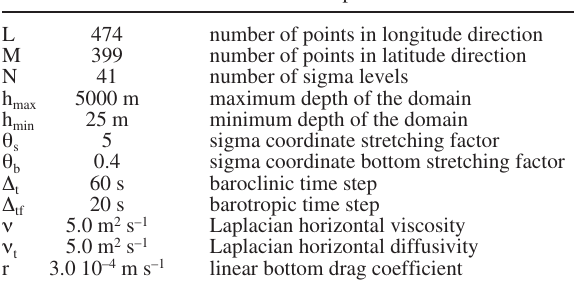
a horizontal spatial resolution of 0.02° and minimum depth of 25 m. The vertical discretization consists of 41 levels following the topography, with h a surface stretching factor of q resolution throughout the surface layers (i.e. boundary layers) of the domain. q is a refinement parameter that